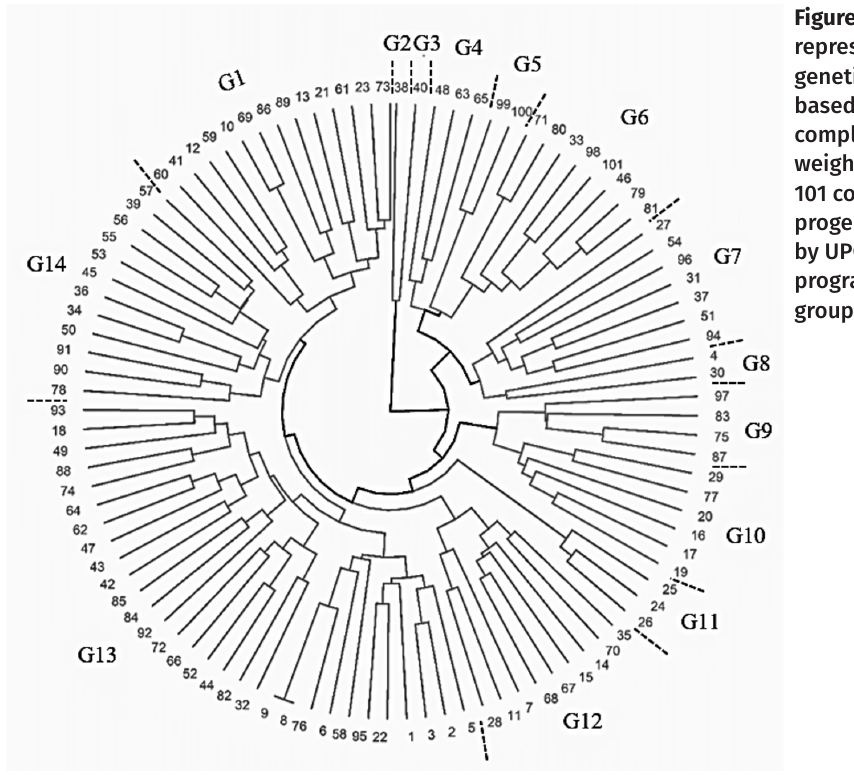
Figure 3. Dendrogram representative of genetic dissimilarity based on the complement of the weighted index in the 101 conilon coffee progenies, obtained by UPGMA using the program R, forming 14